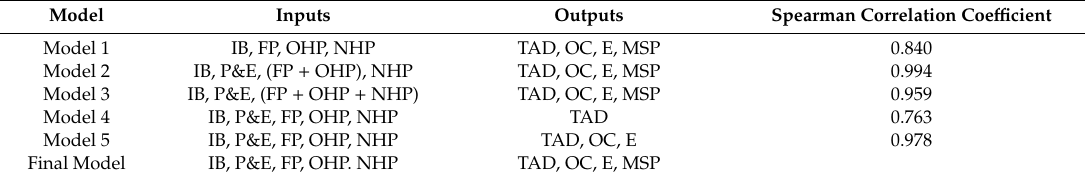
Table A2. Final and alternative models of the analysis of the technical e ffi ciency of Spanish National Health System general